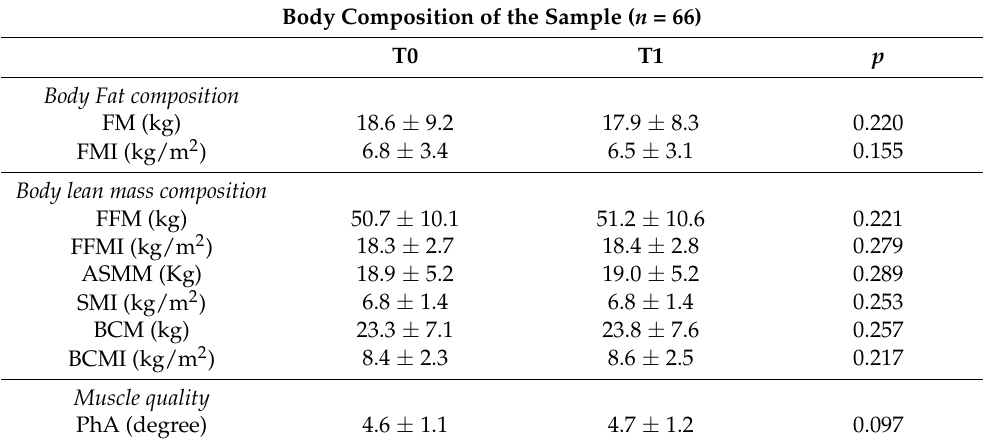
Table 2. Bioelectrical impedance analysis parameters at baseline (T0) and at discharge (T1) of patients enrolled ( n =